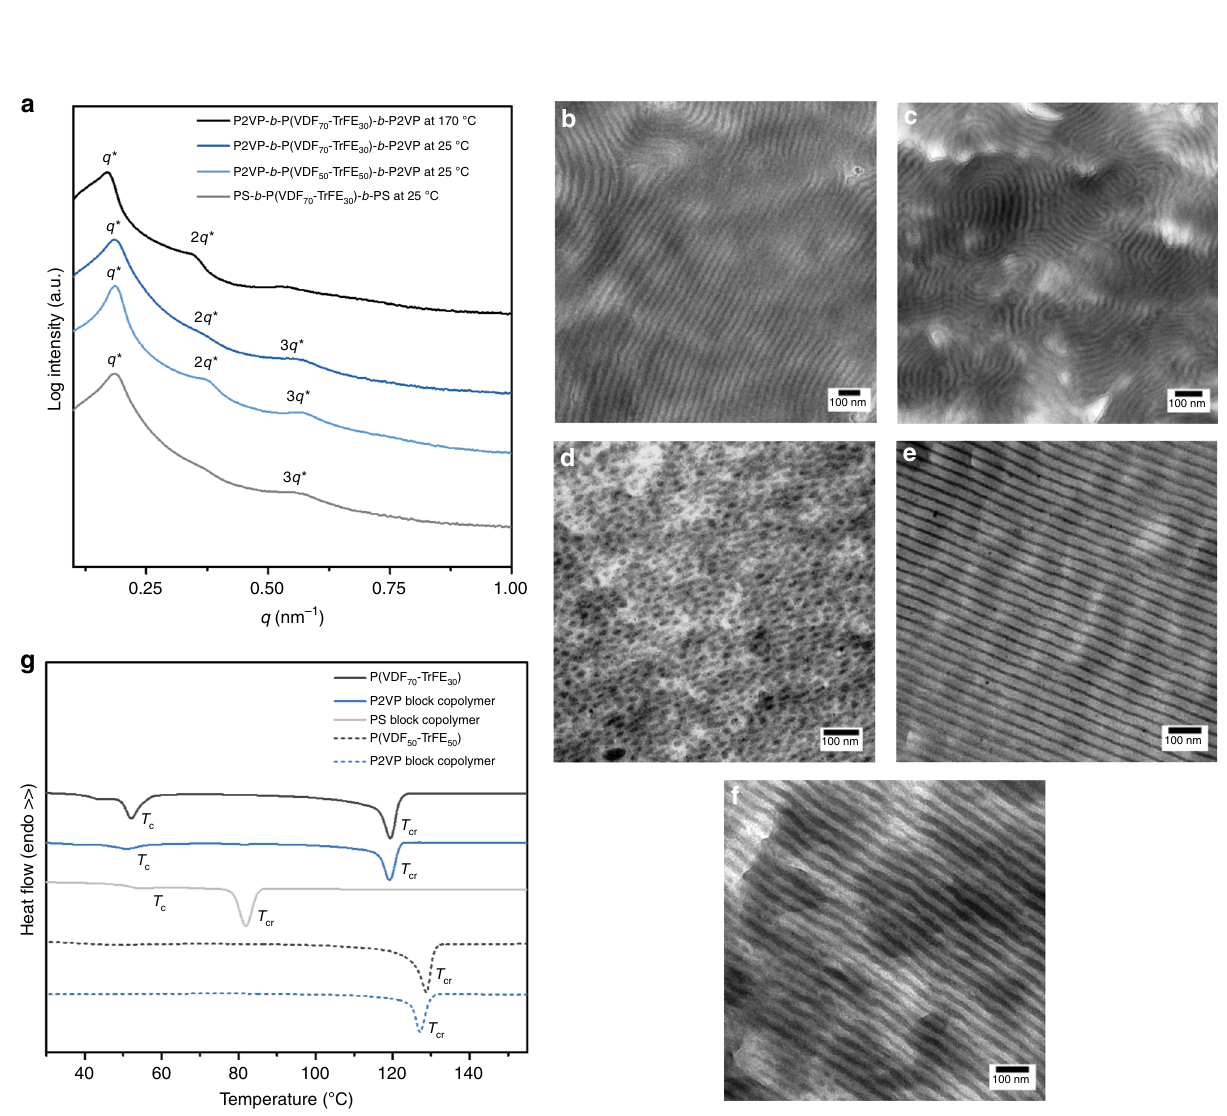
Fig. 3 Structural characteristics of block copolymers. a SAXS pro fi les of the block copolymers prove the con fi nement of the crystallization inside the nanodomains formed in the melt state. TEM images of b P2VP- b -P(VDF 70 -TrFE 30 )- b -P2VP, c P2VP- b -P(VDF 50 -TrFE 50 )- b -P2VP and d PS- b -P(VDF 70 - TrFE 30 )- b -PS after crystallization from the melt demonstrate different segregation strength between blocks. No staining of the block copolymers is required as suf fi cient density contrast exists between crystalline P(VDF-TrFE) and amorphous blocks. Annealing of e the solvent casted PS- b -P(VDF 70 -TrFE 30 )- b -PS with asymmetric lamellar morphology at 120 °C results in f the increase of the crystalline layer thickness without changing the overall lamellar period (See Supplementary Fig. 4). g DSC cooling curve of the pristine P(VDF-TrFE) and corresponding block copolymers, obtained at a cooling rate 10 °C min −